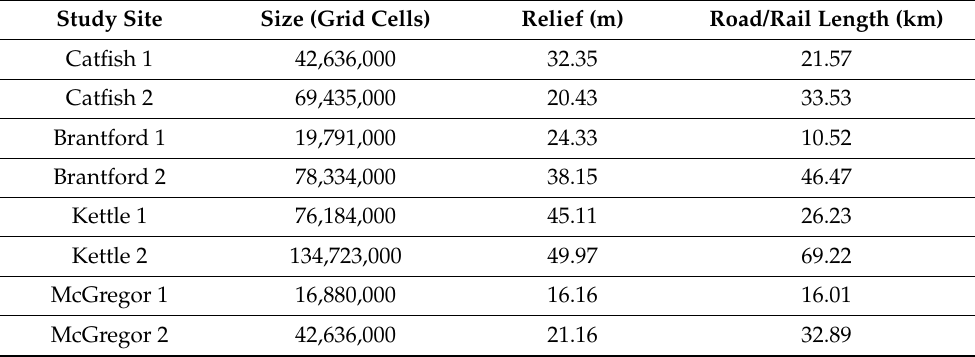
Table 2. Characteristics of the study site DEMs. Relief is the difference between the highest and lowest elevation in a dataset. Road/rail length refers to the total length of the edited transportation network vector, including all roads and railways on